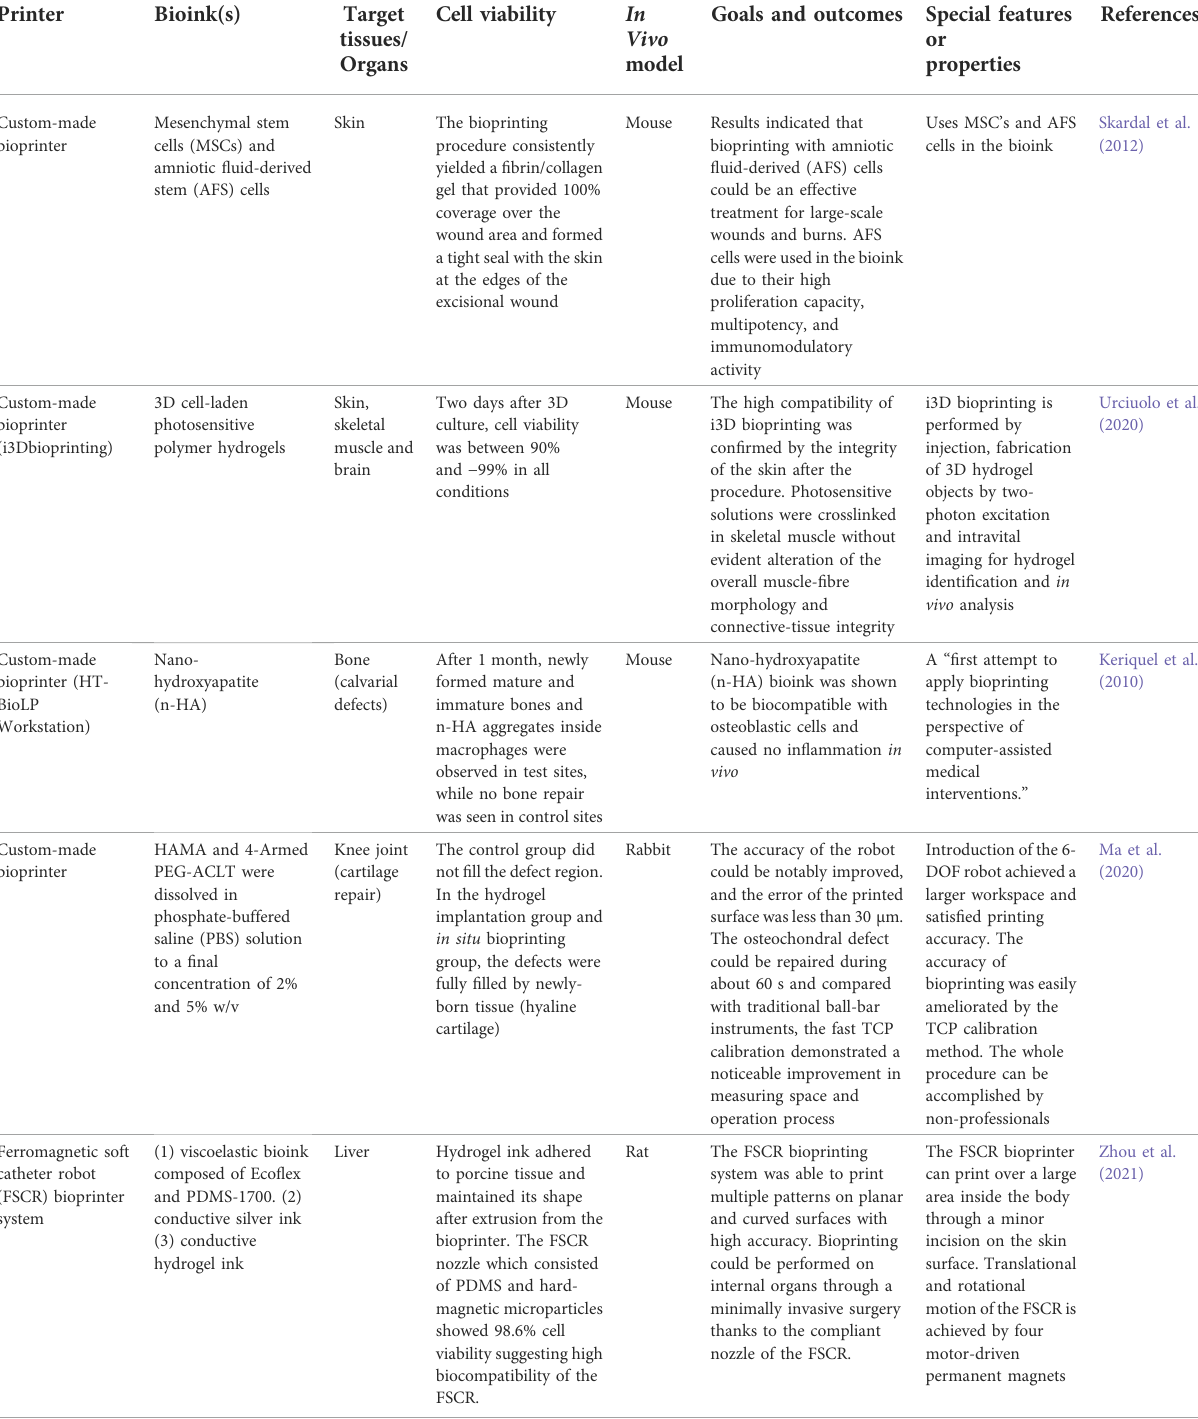
TABLE 1 In situ 3D bioprinting — bedside mounted